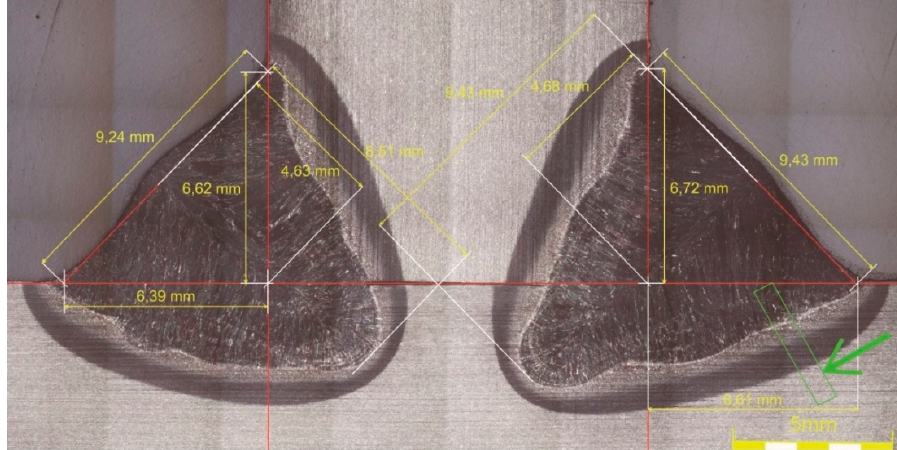
Figure 6. Geometrical evaluation of the weld and the grain size measurement area (green rectangle).